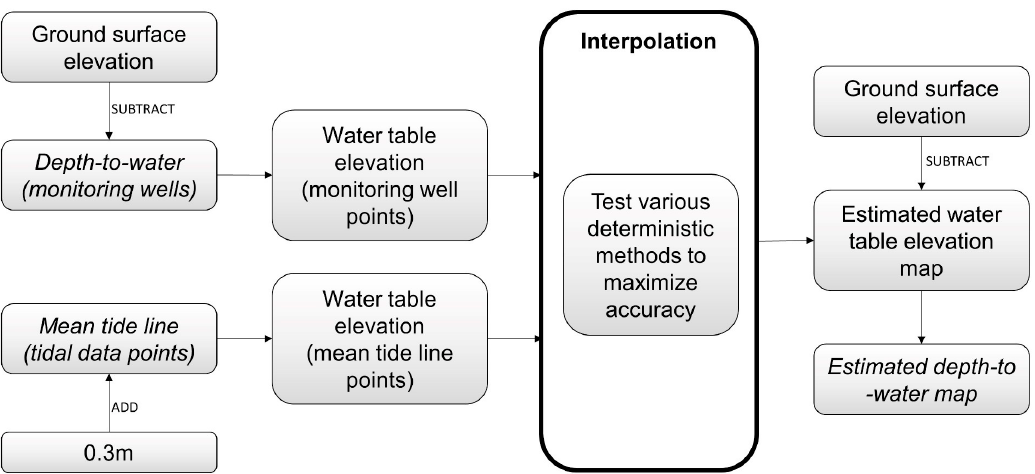
Figure 2. Flowchart of methods. Key inputs and outputs are shown in italics. Both deterministic and geostatistical methods have been used to predict a water table elevation surface from well data in other studies [29–32]. The dataset used here was not well-suited to kriging because it did not fulfill the assumption of stationarity necessary for this method. Data variance was not constant across the study area and could not be explained by directional trends. Given these limitations for geostatistical methods, we only compared deterministic interpolation methods.